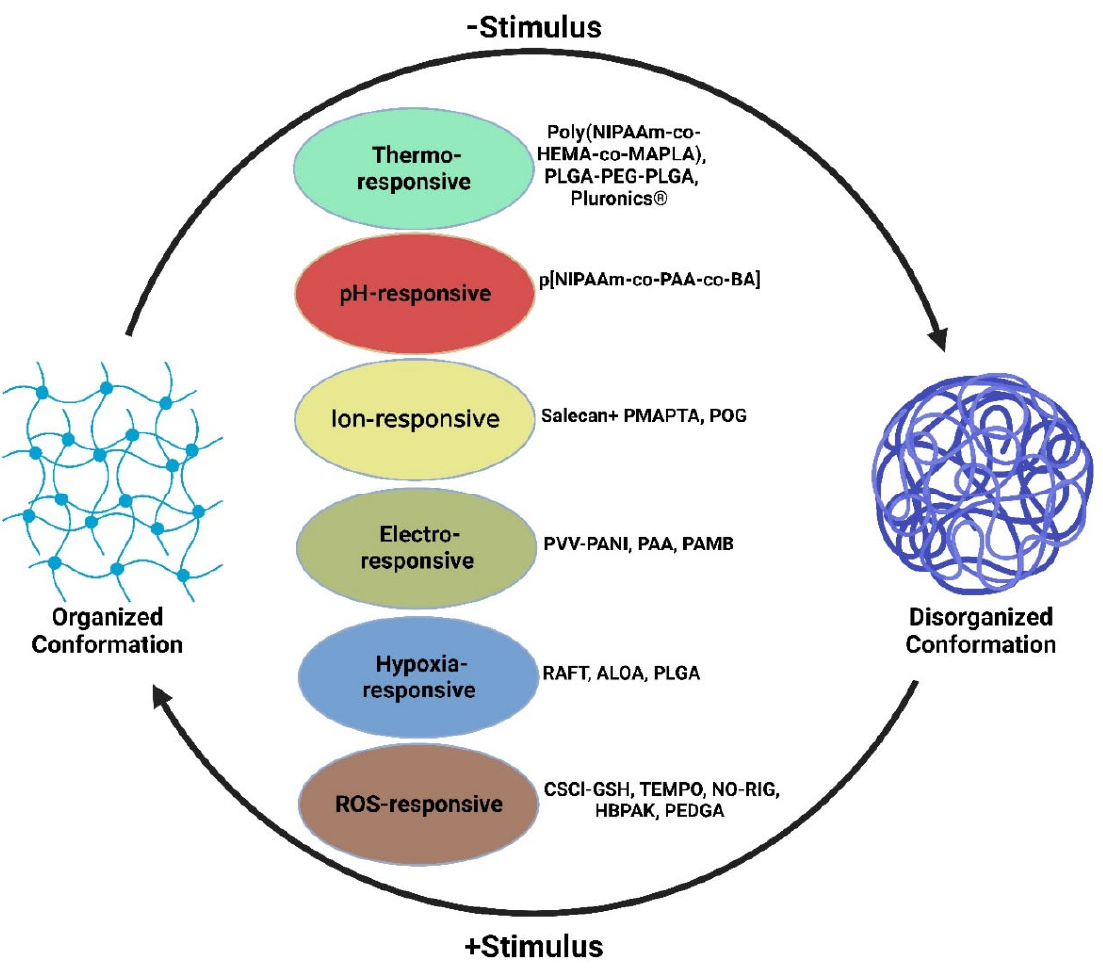
Figure 1. Intelligent hydrogels responsive to various environmental factors such as temperature, pH, ion, ROS, and electrical stimulation are utilized in post-MI cardiac tissue regeneration therapy.